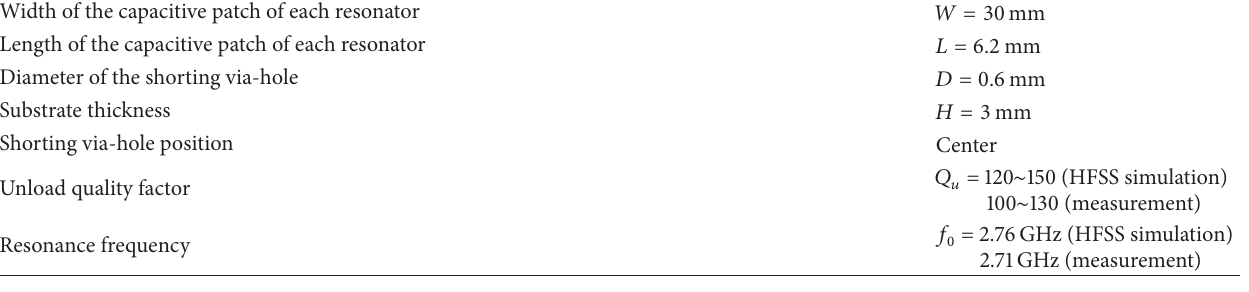
Table 1: Geometrical and electromagnetic characteristics of the filter.